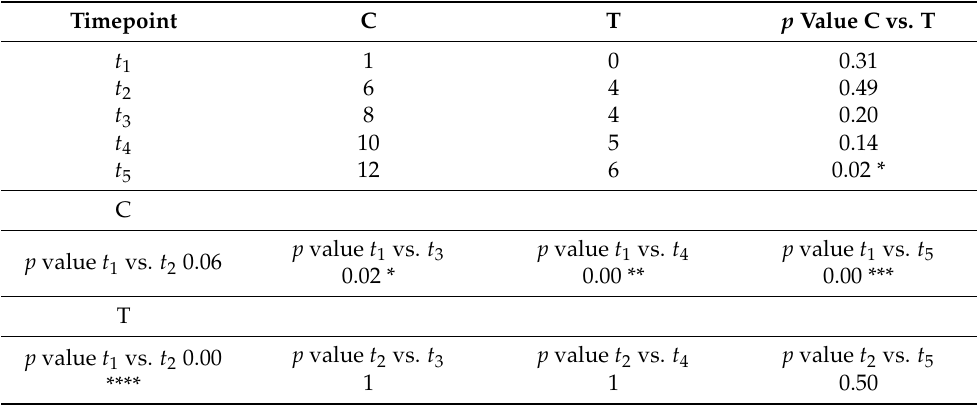
Table 3. Number of patients with WSLs at t 1 , t 2 , t 3 , t 4 , t 5 . WSLs = white spot lesions. C =